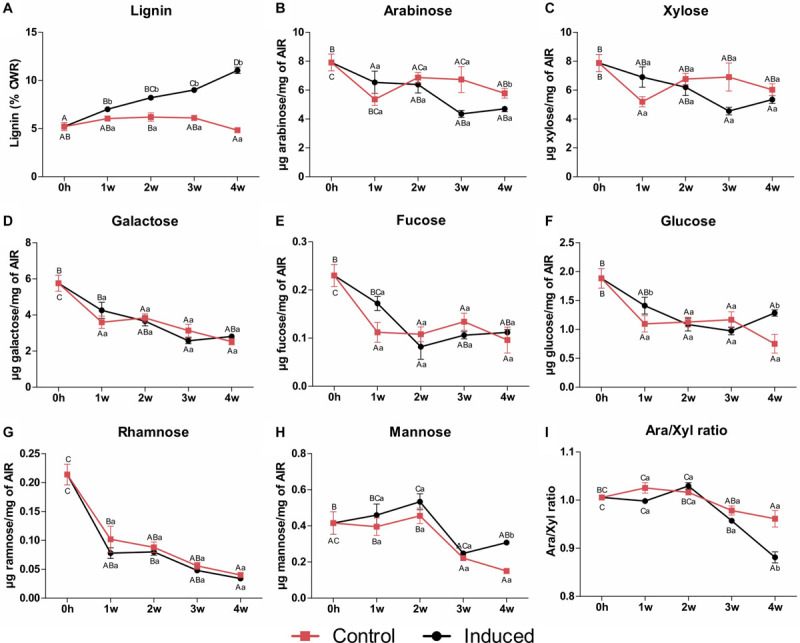
Lignin content and monosaccharide composition of cell wall residues isolated from control and induced sugarcane suspension cells along a time frame of 4 weeks. (A) Lignin content determined by the acetyl bromide method. Data are expressed as percentage of CWR. Error bars represent SE (n = 4). (B–H) Monosaccharide content determined by HPAEC-PAD. Panels indicate (B) arabinose, (C) xylose, (D) galactose, (E) fucose, (F) glucose, (G) rhamnose, and (H) mannose. Data are means ± SE (n = 5). (I) Arabinose to xylose ratio. Data are means ± SE (n = 5). Statistical differences were assessed using one-way ANOVA and Tukey’s post hoc test (P < 0.05) for comparisons along time in the same treatment and using Student’s t-test (P < 0.05) between control and induced samples at each time point. Different uppercase letters represent significant differences along the time series, whereas different lowercase letters represent significant differences between treatments.